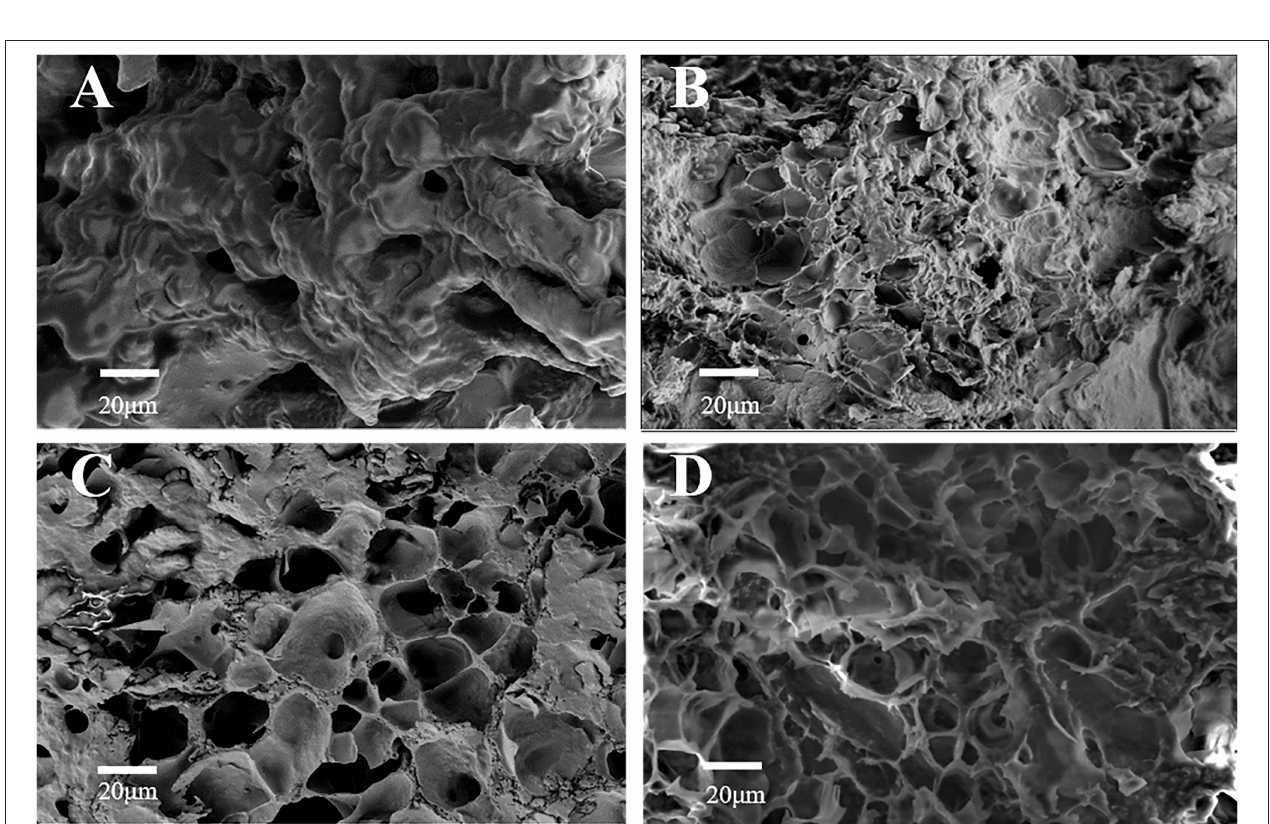
FIGURE 1 | SEM observation of fat substitutes with different formulations, whereas (A) SPI/coconut oil emulsion (S5K4). (B) The addition of konjac. (C) The addition of starch. (D) The addition of TG (S5K4).